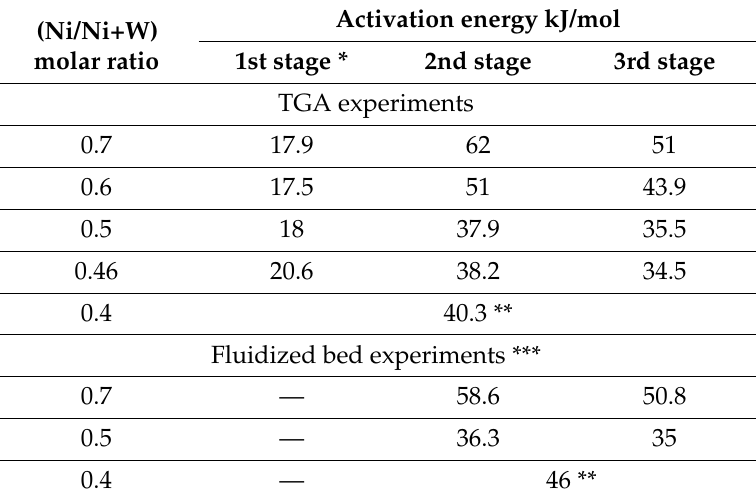
Table 3. Activation energy for different NiO-WO 3 mixtures